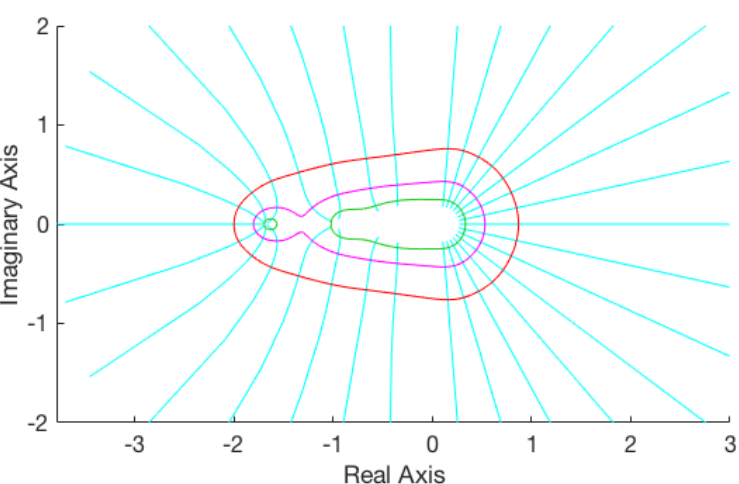
Figure 2. Pseudospectra computations for a non–symmetric sparse matrix of order 1024 from the Harwell-Boeing collection and (cid:101) = 10 − 1 ,10 − 1.5 ,10 − 2